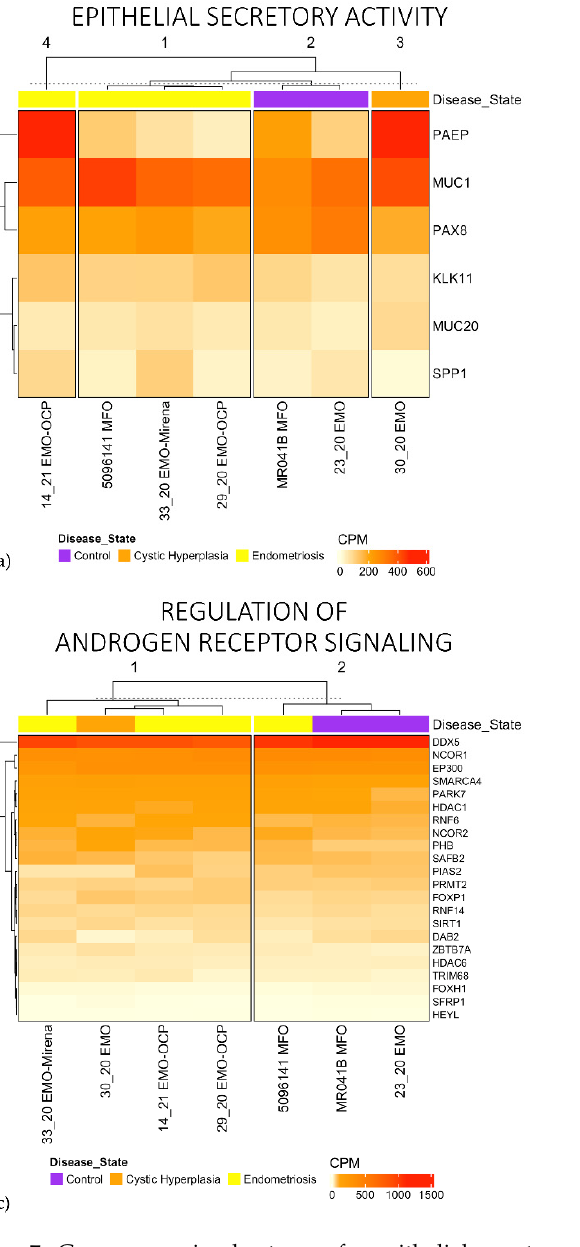
Figure 7. Gene expression heatmaps for epithelial secretory activity ( a ) and Androgen Receptor Signaling ( b ), and its regulation ( c , d ) shows clustering of controls from disease states.